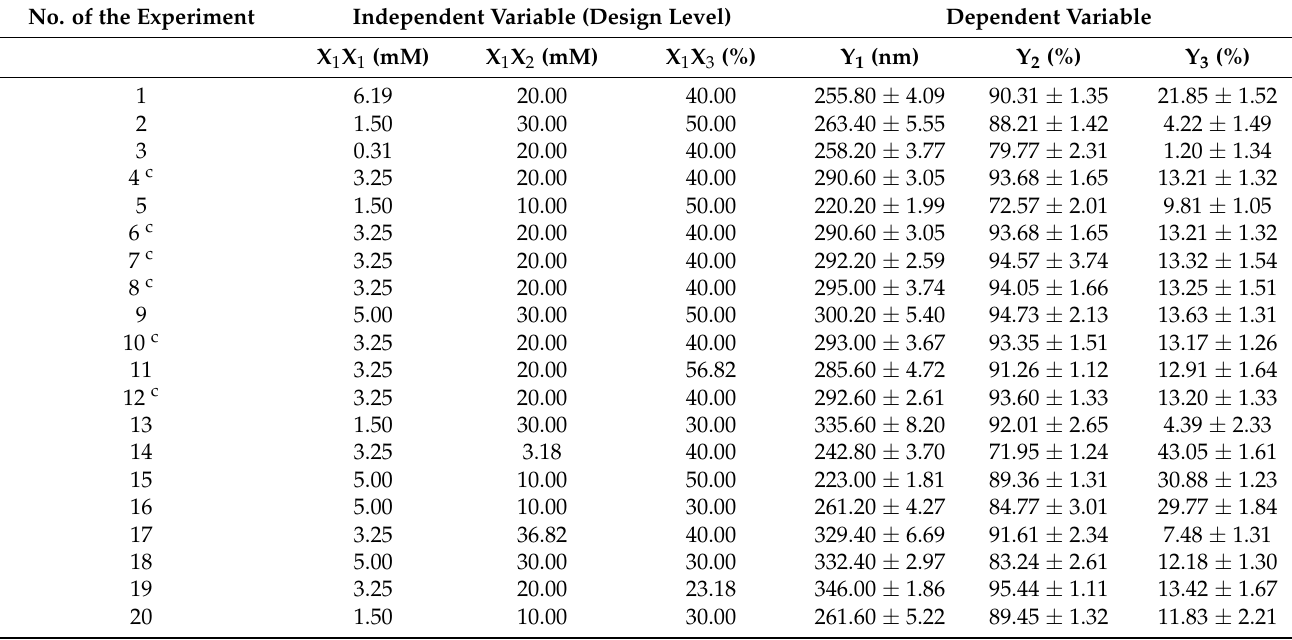
Table 2. Design matrix for the preparation of FLP using orthogonal design.